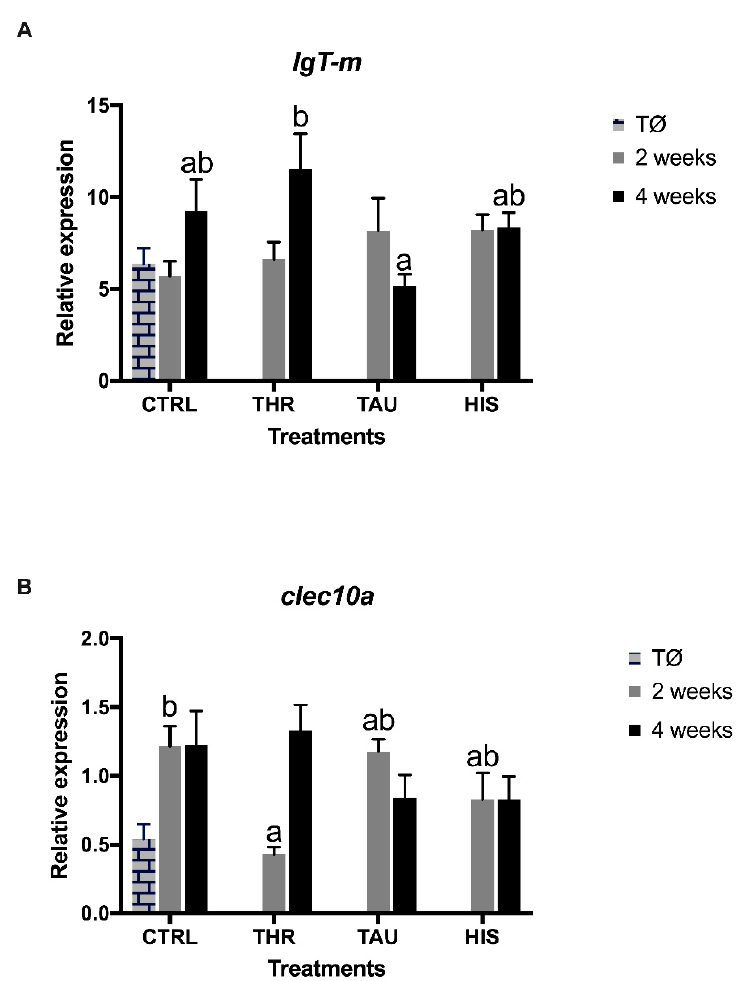
Figure 1. Relative expression of Immunoglobulin T membrane-bound form ( IgT-m , ( A ) C-type lectin domain family 10 member A ( clec10a , ( B ) genes in the head-kidney of gilthead seabream at time Ø and fed the dietary treatments during two and four weeks. Values are presented as means ± SE ( n = 9). p -values from two-way ANOVA ( p ≤ 0.05). Tukey’s post-hoc test was used to identify differences in the experimental treatments. a,b: Different lowercase letters stand for significant differences among dietary treatments for the same sampling time. treatment.control (CTRL), histidine (His), taurine (Tau), and threonine (Thr)